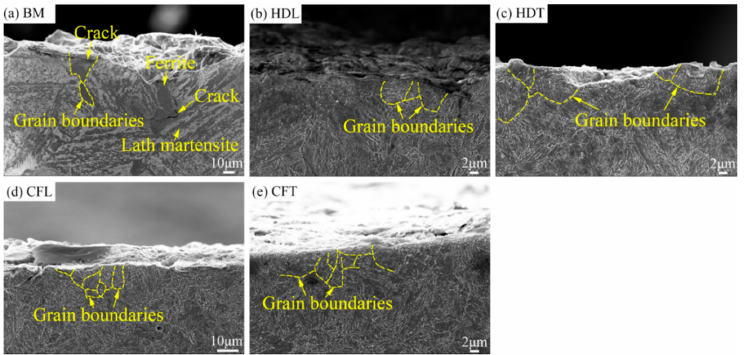
Figure 12. The cross-section fracture morphologies of ( a ) BM; ( b ) HDL; ( c ) HDT; ( d ) CFL, and ( e ) CFT.